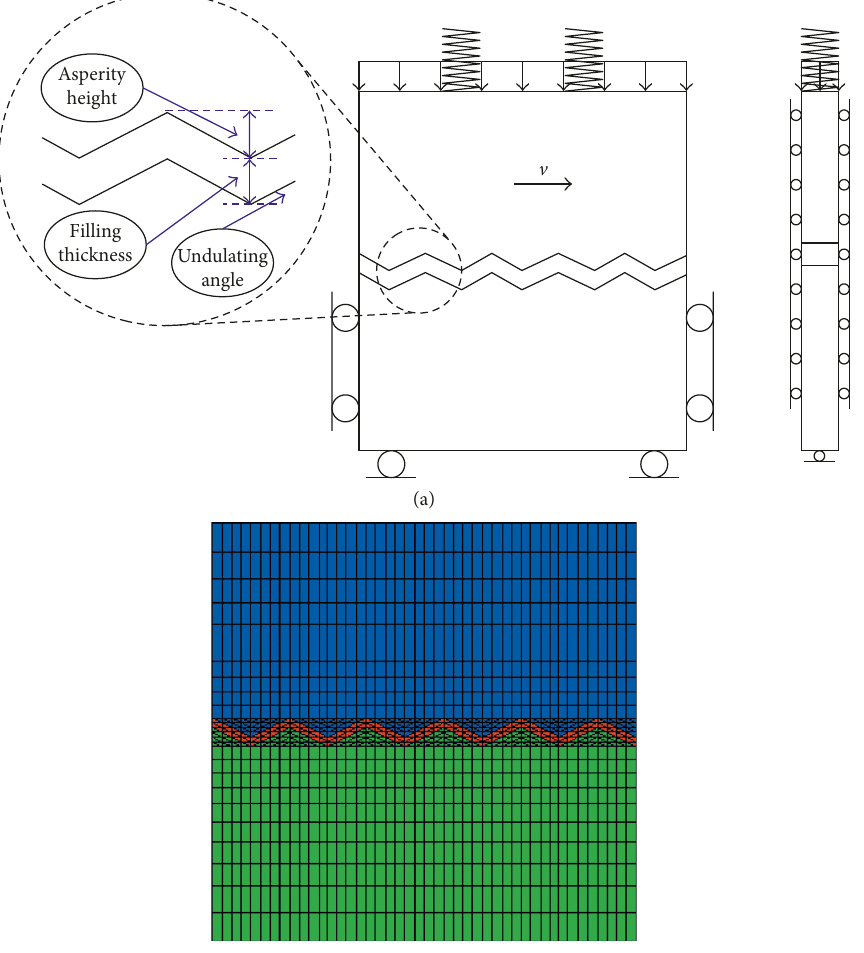
Figure 1: (a) Concept model and (b) numerical model of the infilled